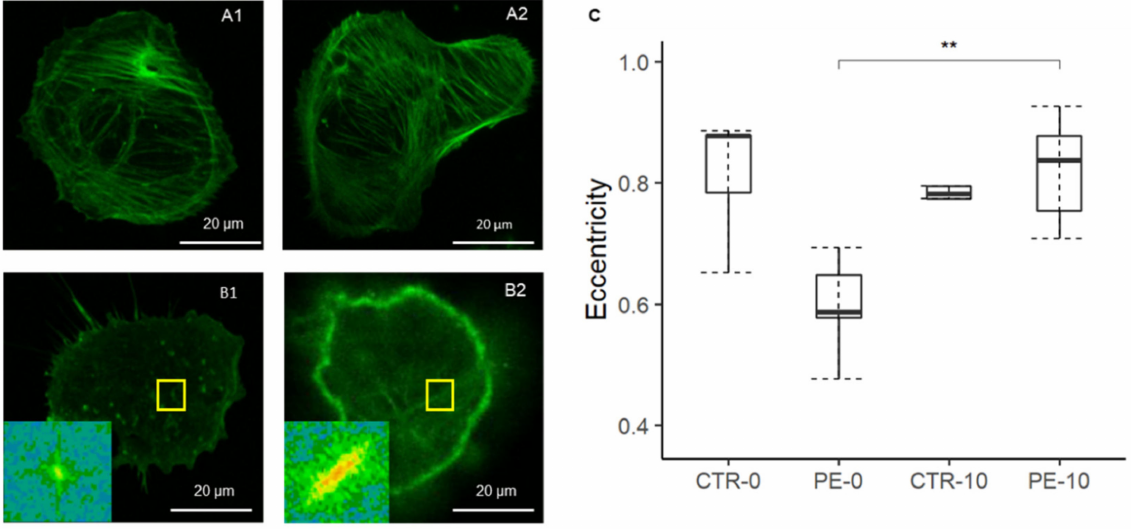
Figure 2. ( A1 – B2 ) F-actin staining of trophoblast cells from normal pregnant ( A1 , A2 ) and PE ( B1 , B2 ) women before ( A1 , B1 ) and after ( A2 , B2 ) LMWH incubation (10 UI/mL) for 24 h. ( C ) F-actin poly- merization analyzed as eccentricity is significantly reduced in PE compared to controls. Incubation of trophoblast cells with LMWH significantly improved F-actin polymerization and cytoskeleton spatial organization. No significant difference was found in cells obtained from normal pregnant women after treatment with LMWH. Data are expressed as median with related confidence interval. ** p <